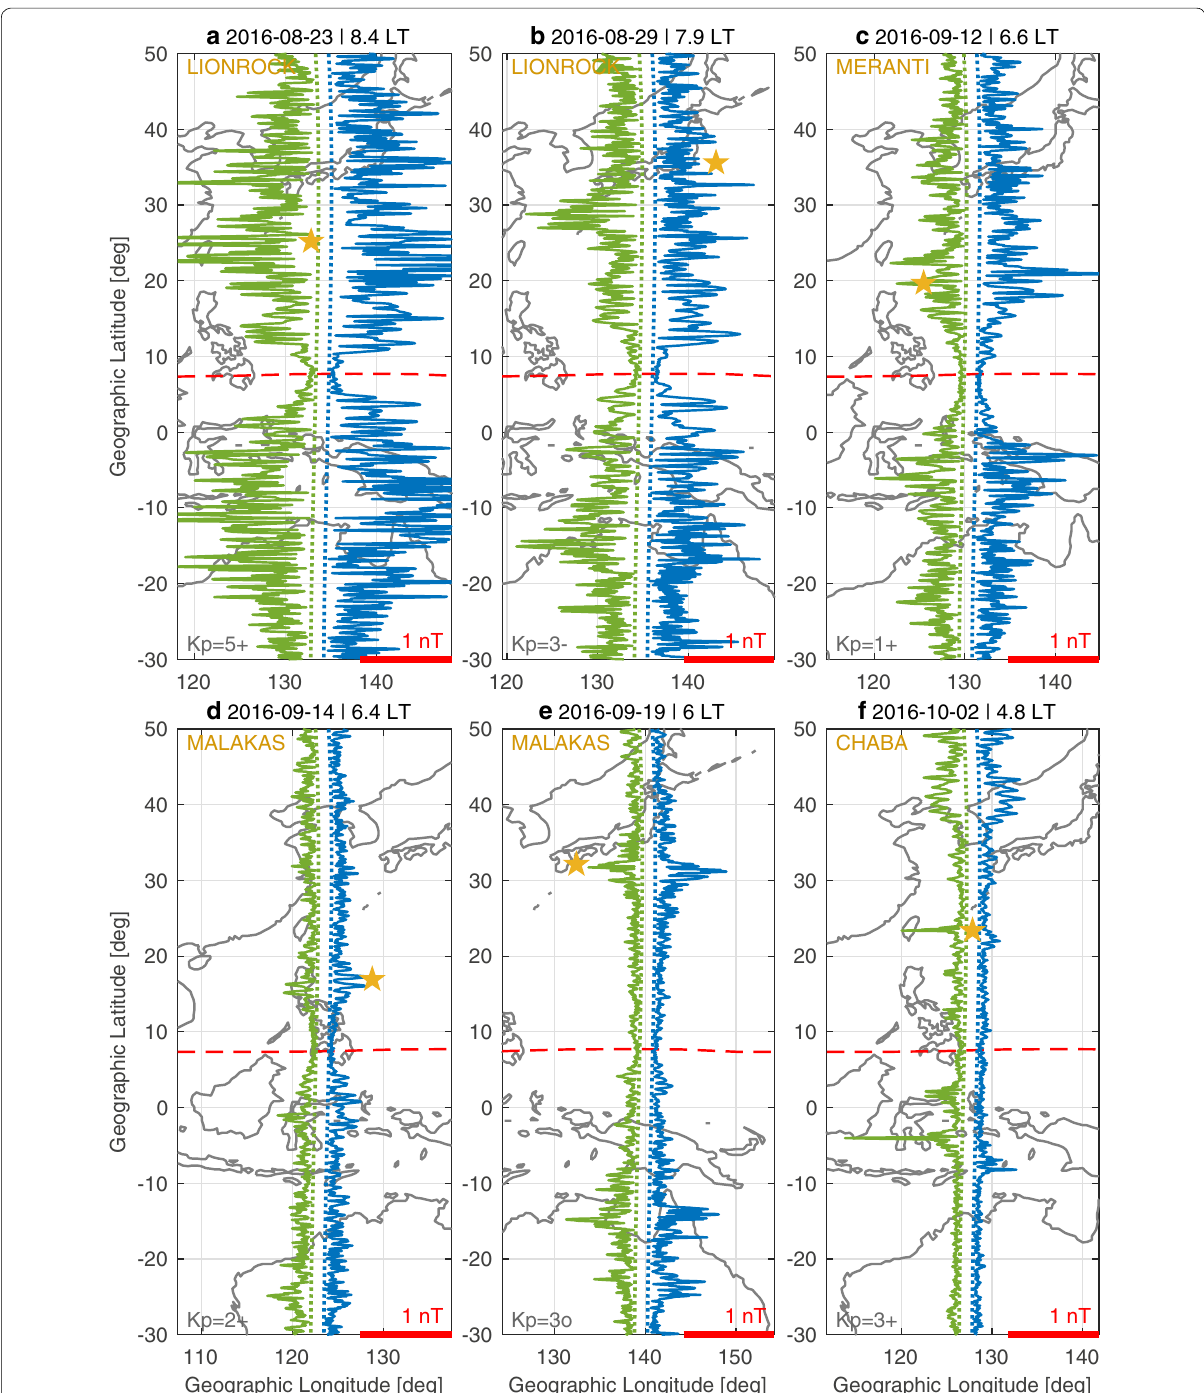
Fig. 9 Typical examples of the MRs during typhoon activity on the dawn (or morning) side simultaneously observed by both SW-A and SW-C. The solid green and blue , and dotted green and blue lines indicate total MR amplitudes from SW-A and SW-C, and orbits of the SW-A and SW-C, respec- tively. The yellow stars and dotted red lines indicate the center of the typhoons and dip equator,